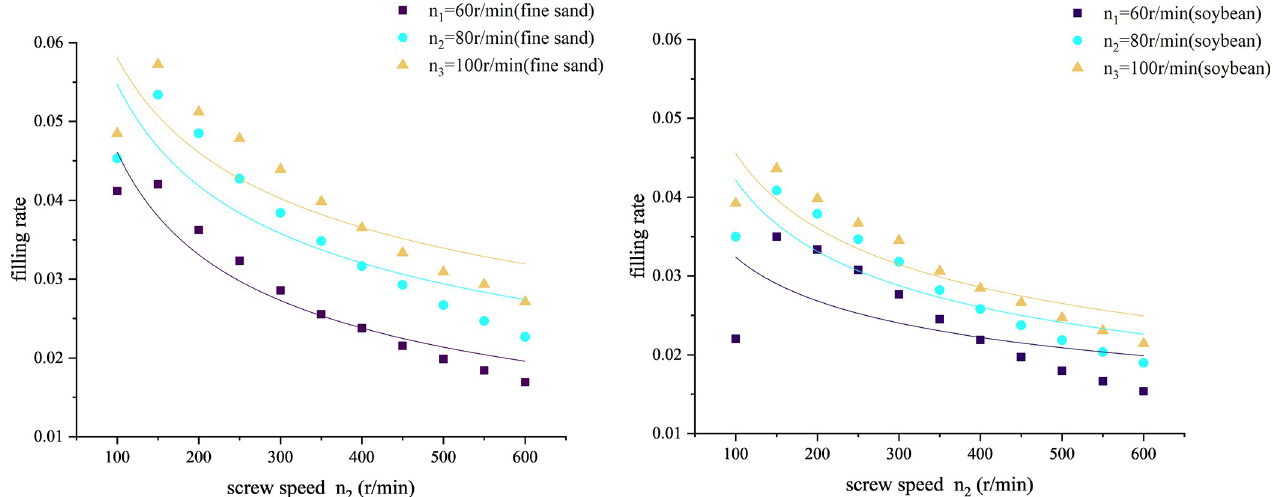
Fig 8. Curve of filling rate versus screw speed n 2 . (A) Material: sand. (B) Material: soybean.